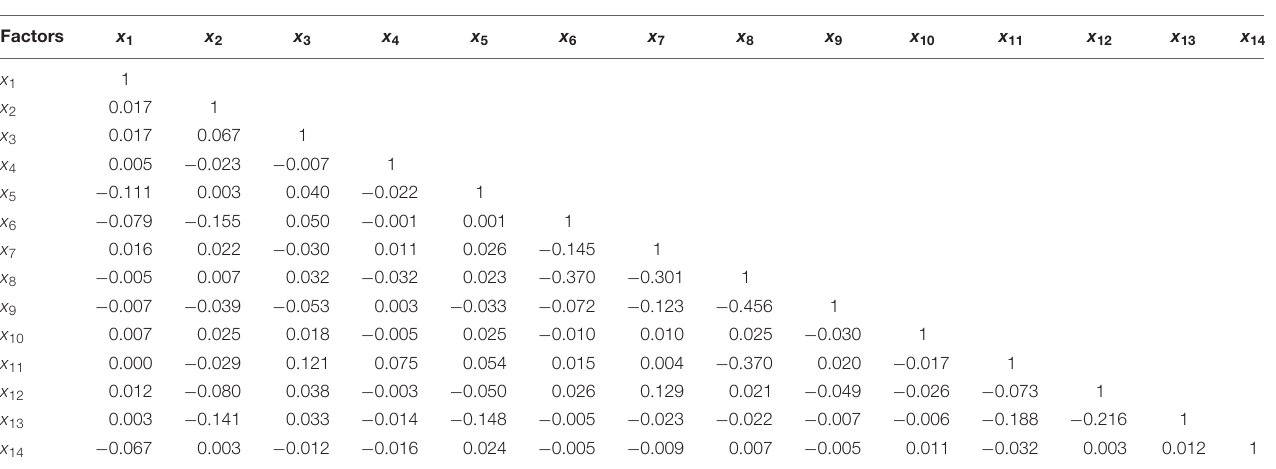
TABLE 3 | Correlation matrix of 14 geo-environmental factors.